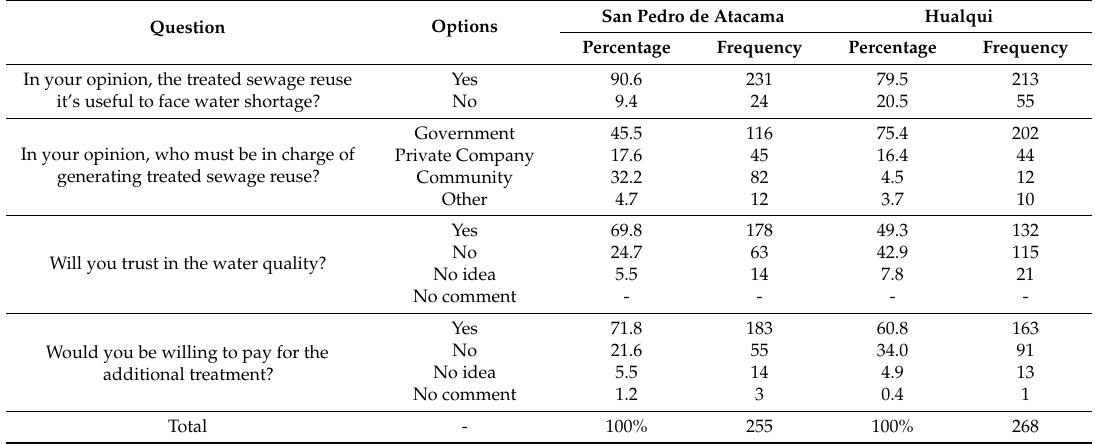
Table 6. Perception of community in San Pedro de Atacama and Hualqui toward treated sewage reuse.